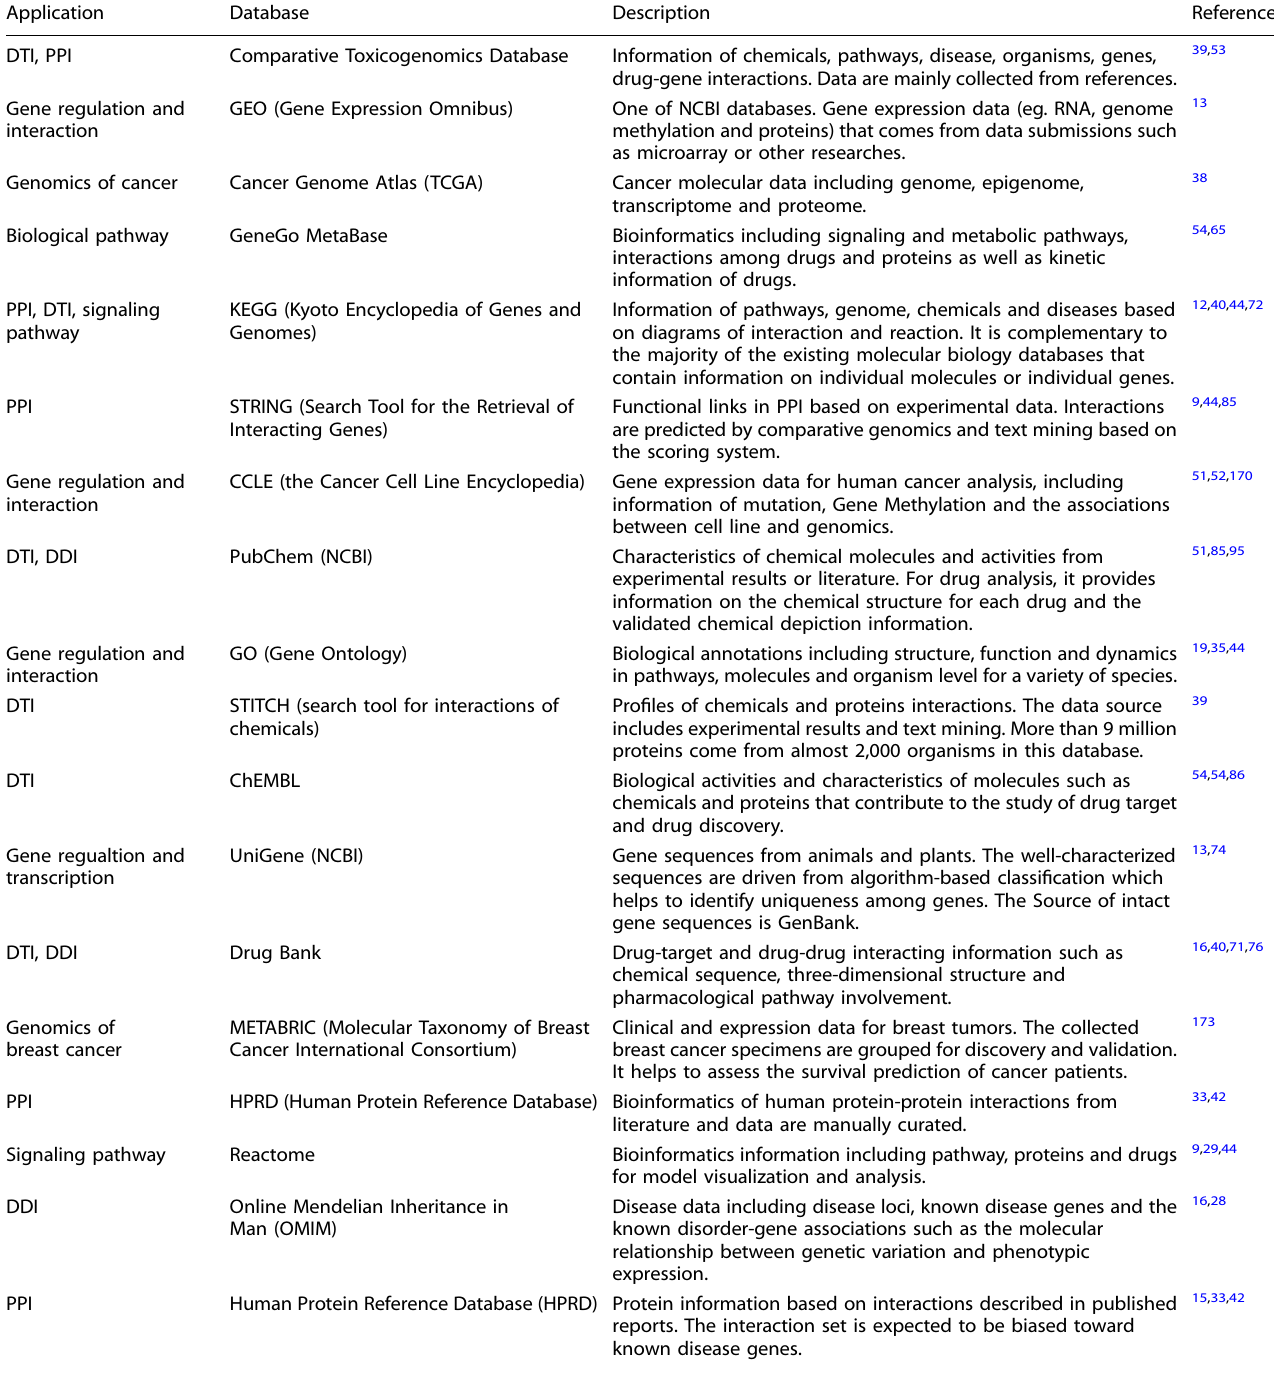
Table 2. Databases for gene and protein interaction